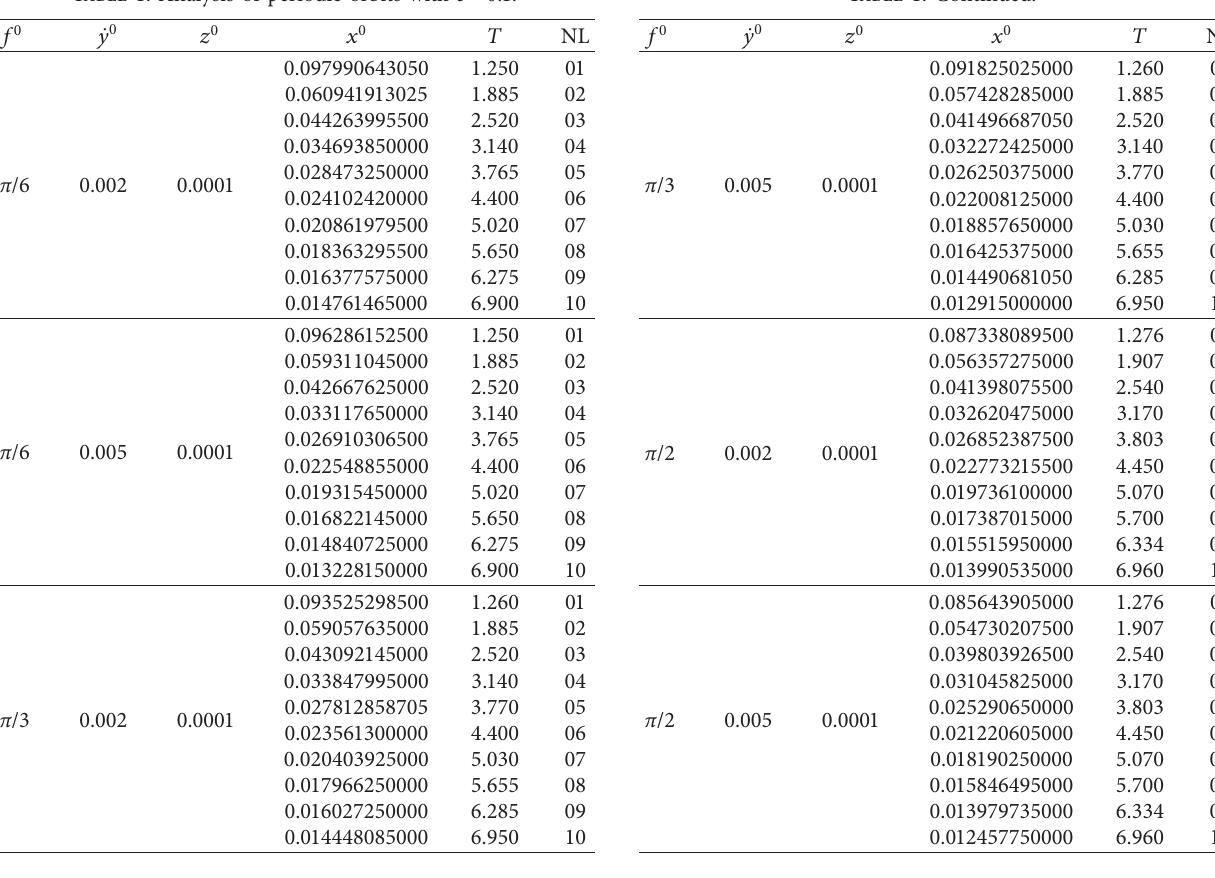
Figure 6: Variation in the initial position of deputy satellite and orbital period when e � 0 . 1. (a) Velocity _ y 0 � 0 . 002. (b) Velocity _ y 0 � 0 . 005. Table 1: Analysis of periodic orbits with e �